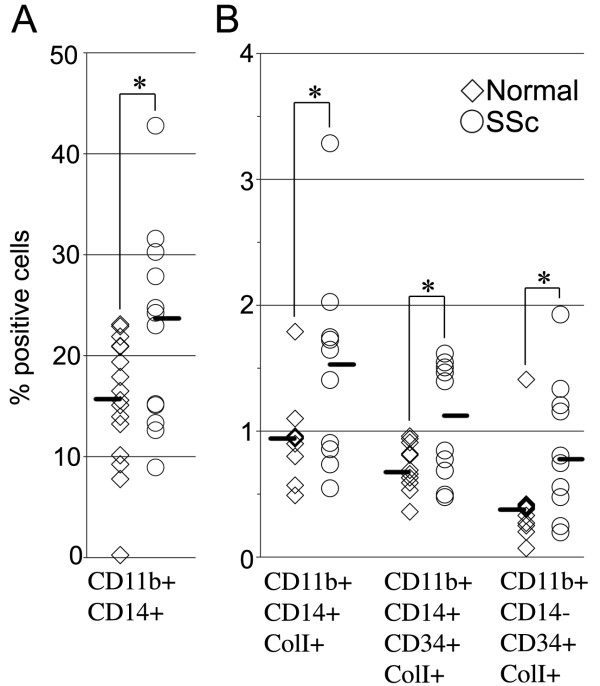
Phenotype of SSc-ILD and normal monocytes. PBMCs were isolated and analyzed by using flow cytometry as indicated for their expression of ColI, CD11b, CD14 and CD34. Each symbol represents the results obtained with cells from a different donor. The median value obtained in each category for SSc-ILD patients and normal donors is indicated by a line. (A) Double-labeled analysis. Note that among CD11b+ monocytes, CD14+ cells are more prevalent among SSc-ILD cells than among normal cells. (B) Triple- and quadruple-labeled analyses. Note that CD14+/ColI+, CD14+/CD34+/ColI+, and CD14-/CD34+/ColI+ cells are more prevalent among SSc-ILD CD11b+ monocytes than among normal CD11b+ monocytes. *P < 0.05.